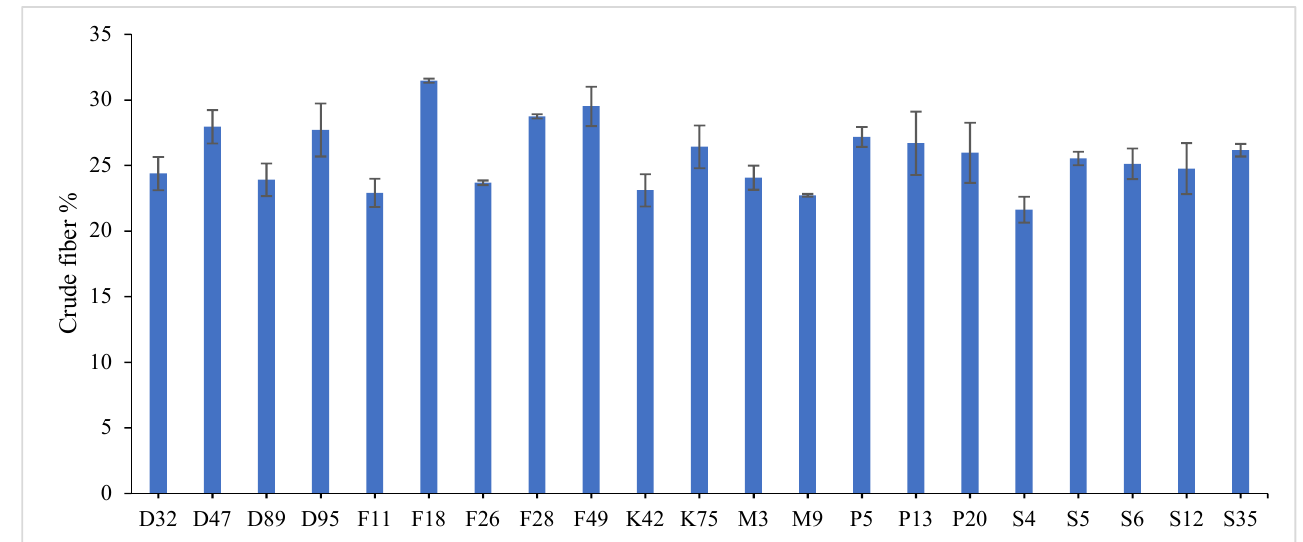
Figure 6. Mean performance of crude protein % of twenty-one alfalfa genotypes in the first year. Bar represents the standard deviation.